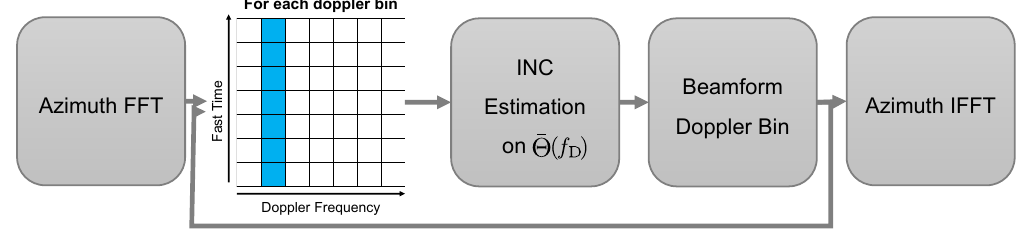
Figure 12. Doppler-Dependent MVDR RFI mitigation with DBF. A mitigation of M − 1 interferers per Doppler bin is possible.